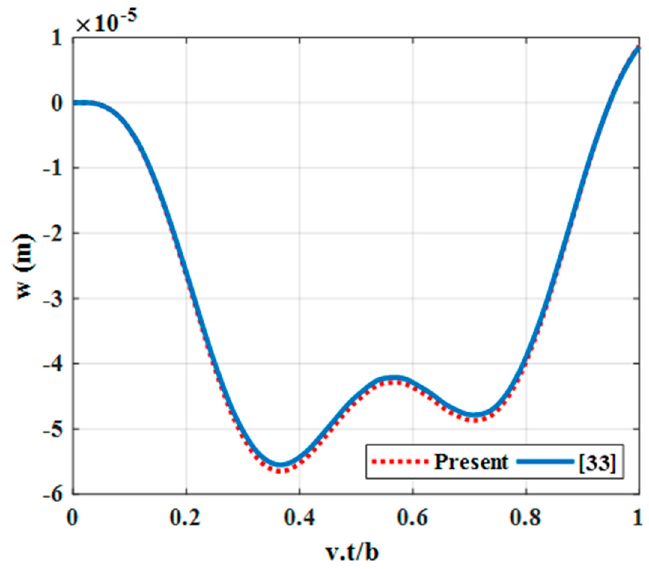
Figure 3. Dynamic deflections of the center point of the SFSF rectangular plate versus time.